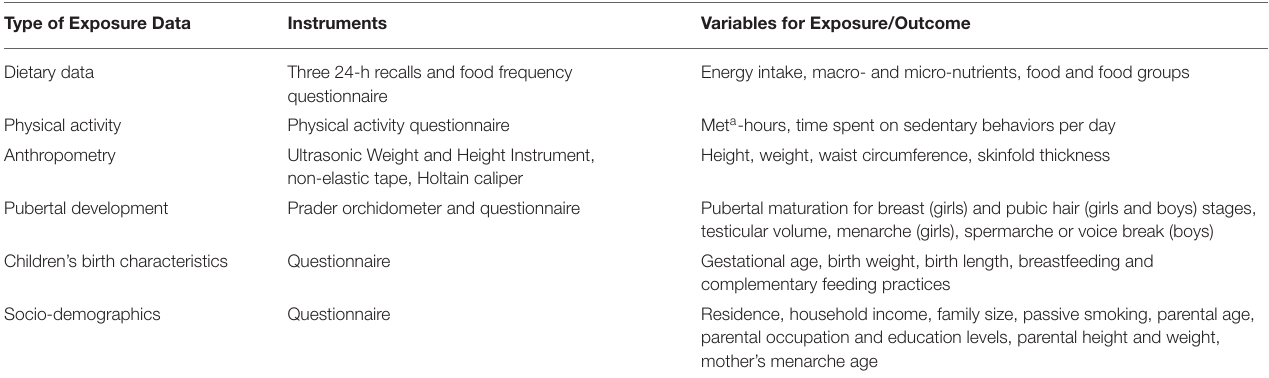
TABLE 1 | Variables and instruments to be used in the Chinese Adolescent Cohort (CAC)